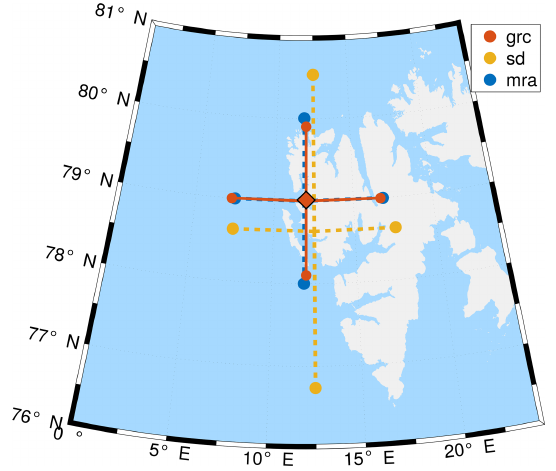
Figure 1. Location of the data points of GROMOS-C, MERRA-2 and SD-WACCM at 3hPa (37km) which are used to calculate the ozone gradient above Ny-Ålesund (indicated with a red